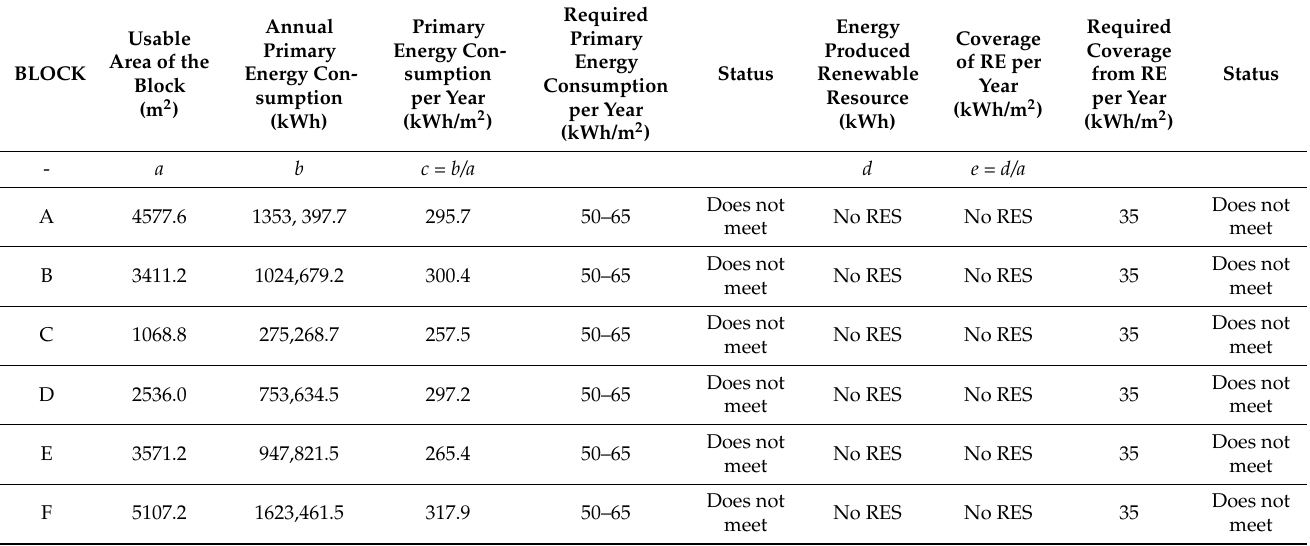
Table 15. Primary energy consumption and coverage from RE for the state before reconstruction.